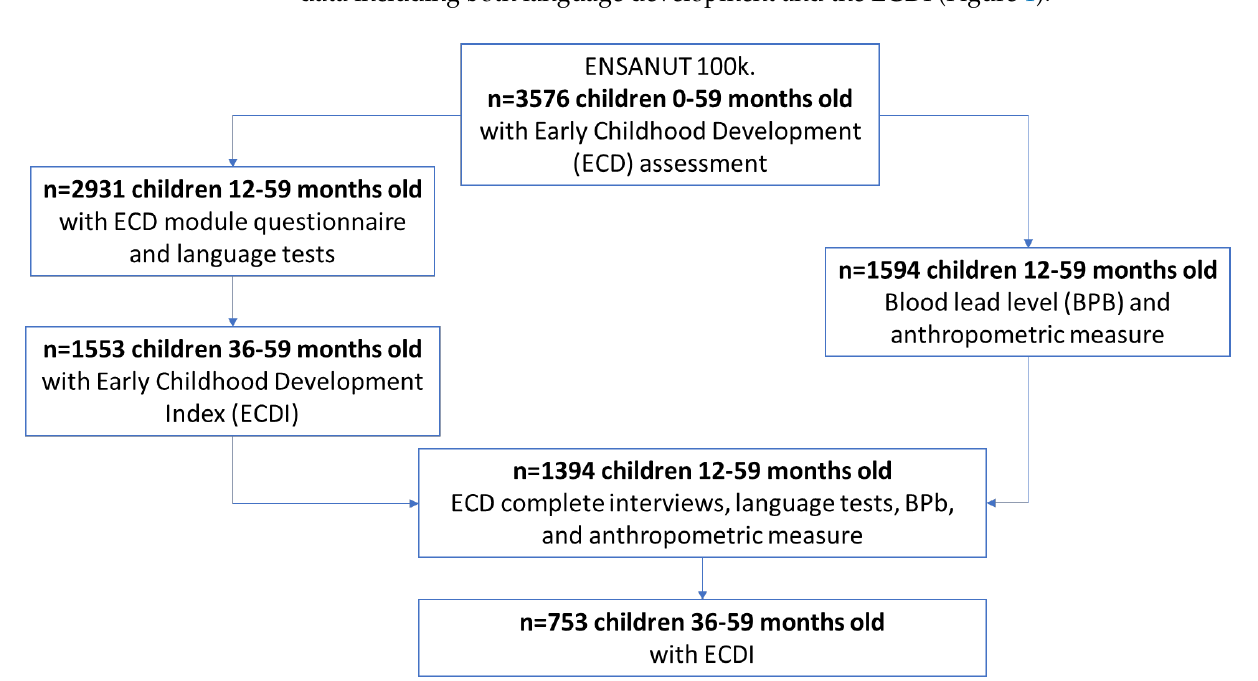
Figure 1. Descriptive diagram of the study population.